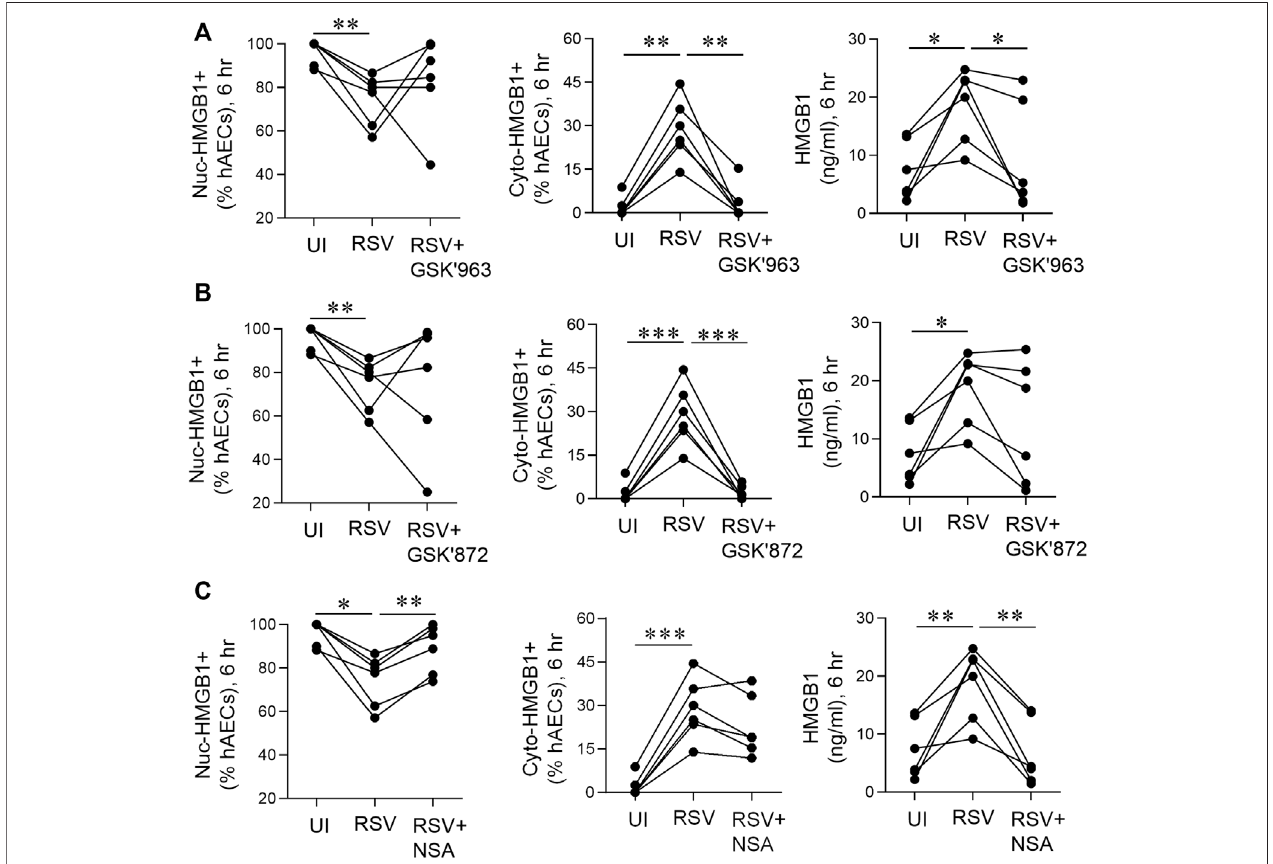
FIGURE6| pMLKL inhibitiondecreasesearlyHMGB1releaseinducedbyRSV.hAECswerepre-treated withorwithoutapRIPK1, pRIPK3orpMLKL inhibitorand infected with RSV (MOI of 1). Endpoints were assessed 6 hpi. (A) Quanti fi cation of nuclear and cytoplasmic HMGB1 positive hAECs and HMGB1 protein expression in the supernatant after pRIPK1 inhibition. (B) Quanti fi cation of nuclear and cytoplasmic HMGB1 positive hAECs and HMGB1 protein expression in the supernatant after pRIPK3inhibition. (C) Quanti fi cation ofnuclearandcytoplasmicHMGB1positivehAECsandHMGB1protein expressioninthesupernatantafterpMLKL inhibition. The same data in the UI and RSV groups are used repeatedly across panels (A – C) . Data are presented as dot plots with each data point representing one of 6 donors. Data were analyzed using a one-way ANOVA and Sidhak ’ s multiple comparisons test. * p < 0.05, ** p < 0.01, *** p < 0.005, denotes signi fi cance between different treatment